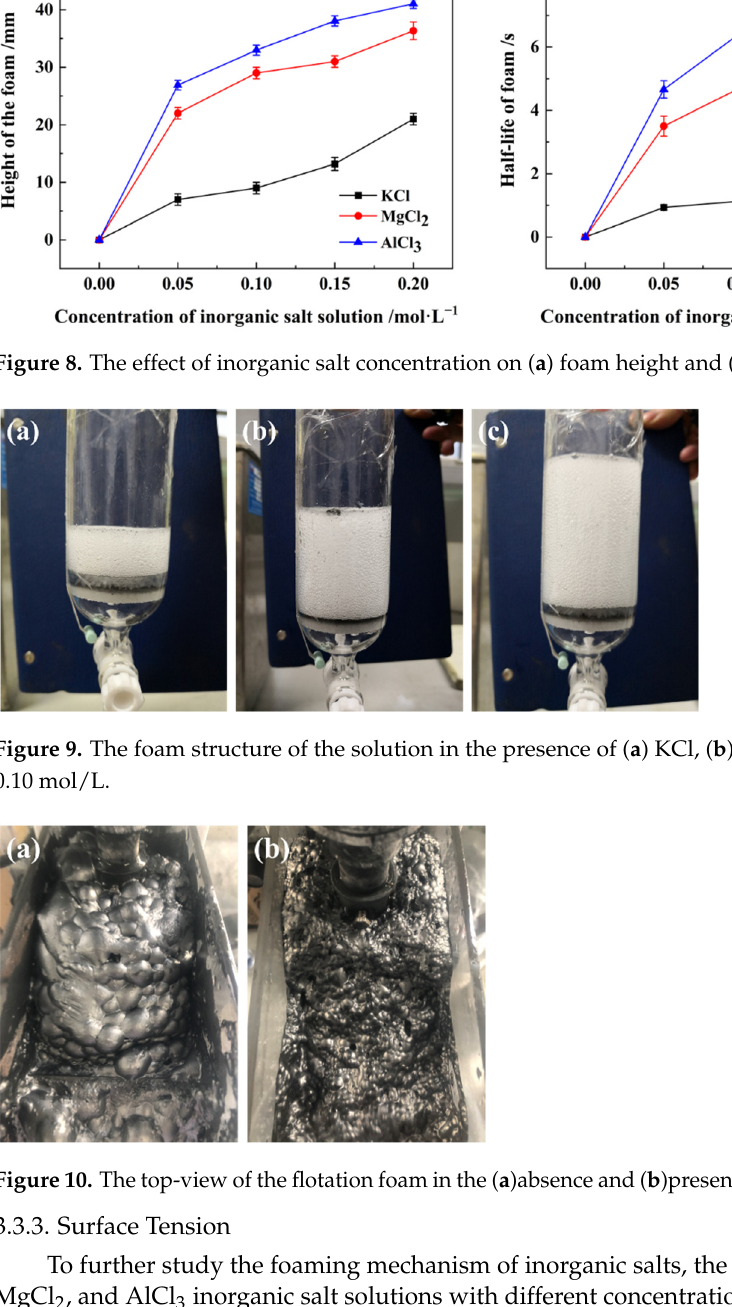
Figure 10. The top-view of the flotation foam in the ( a )absence and ( b )presence of MgCl 2 at 0.2 mol/L.